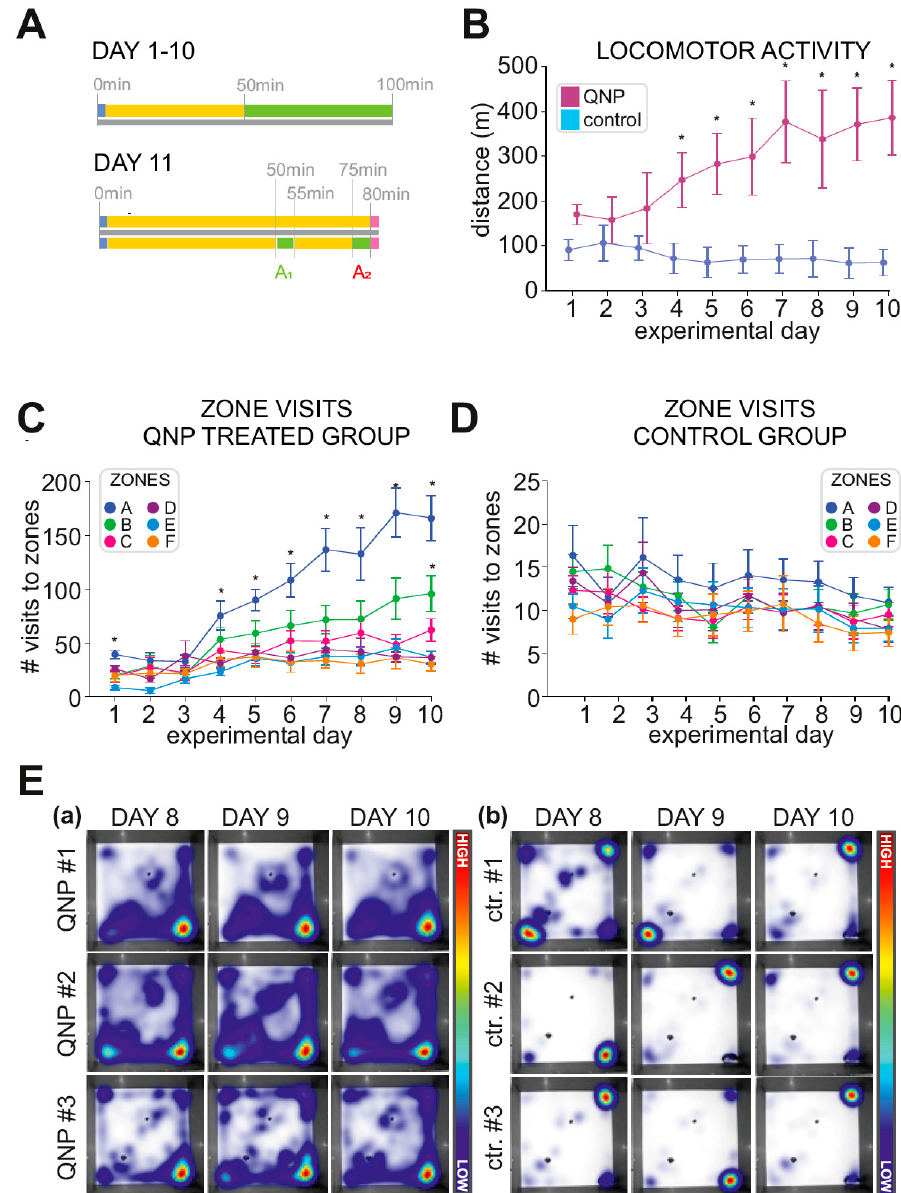
Figure 1. Stereotyped checking in rats repeatedly treated with quinpirole. ( A ) Experimental scheme: During experimental days 1–10 rats received an injection of quinpirole (QNP; 0.5 mg/kg; n = 15) or saline (1 mL/kg; n = 14) 50 min prior to arena exposure. Rats were then placed into the arena and left to explore for 50 min. On experimental day 11 rats were injected by QNP or saline. After 50 min rats were placed into the arena for 5 min (A 1 ), and returned back to the home cage. After 20 min, rats were placed into the arena for the second 5 min exposure (A 2 ). Immediately after, rats were sacrificed. 5 QNP-treated rats and 5 saline-treated control rats were kept in the home cage during sessions A 1 and A 2 to determine baseline immediate early gene (IEG) expression. ( B ) Locomotor activity of quinpirole (QNP) treated and control rats on experimental days 1–10. QNP treated rats elapsed significantly longer distances than control rats ( p < 0.001) on experimental days 4–10. ( C ) Visits to zones A–F by QNP treated rats. Zone A denotes the most visited zone, while F denotes the least visited zone from all visits to zones pooled together. QNP treated rats visited zone A significantly more than zones B-F on experimental days 1 and 4–10 ( p < 0.001) and visited zone B significantly more than zones C–F on day 10 ( p < 0.05). ( D ) Visits to zones A–F by control rats. Control rats did not visit any zone significantly more than any other. ( E ) Heat-maps illustrate that individual quinpirole (QNP) treated rats had very similar behavioral patterns between experimental days 8, 9, and 10, while locations visited by individual control rats varied between experimental days 8, 9, and 10. Panel ( a ) shows locations visited by three sample QNP treated rats in the last three days of treatment (days 8–10). Panel ( b ) shows locations visited by three sample control